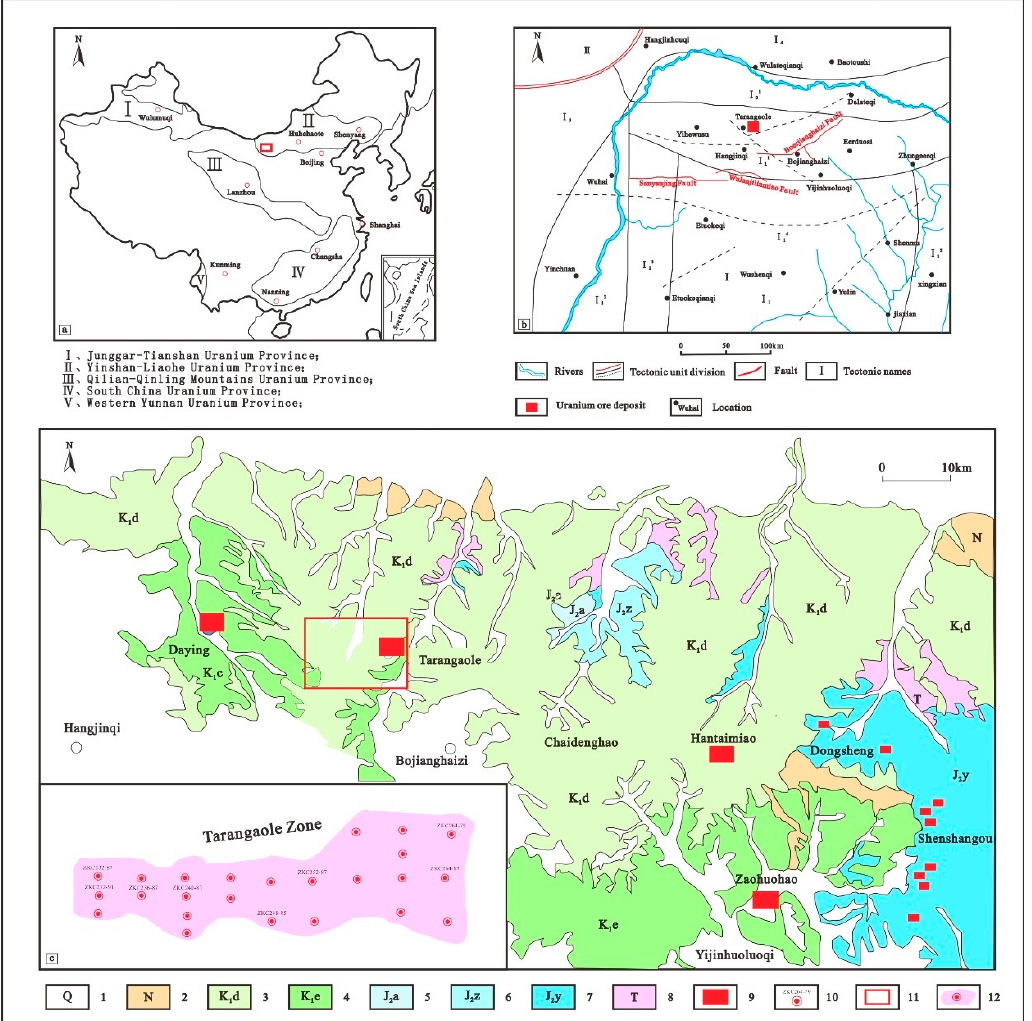
Figure 3. Tectonic map of the study area (after Lulu Chen et al. [31]). 1. Quaternary; 2. Neogene; 3. Dongsheng Formation; 4. Ejin Horo Formation; 5. Anding Formation; 6. Zhiluo Formation; 7. Yan’an Formation; 8. Triassic; 9. Uranium deposit; 10. Borehole; 11. study Area; 12.